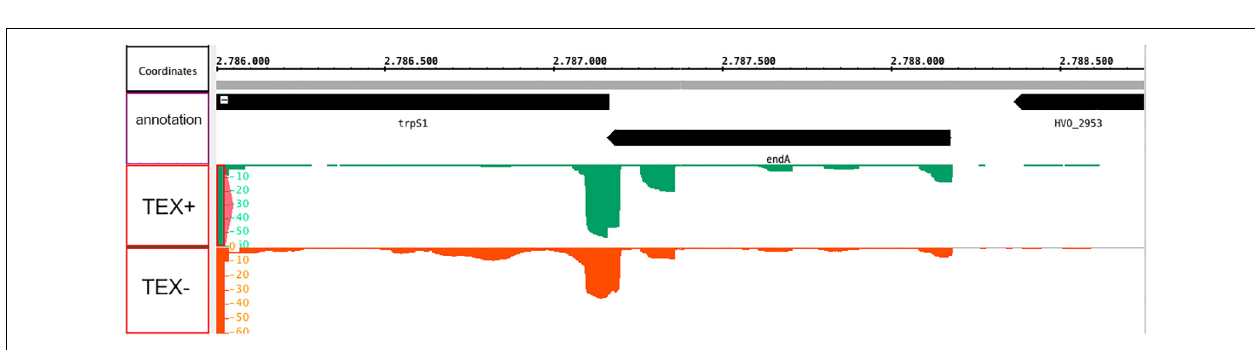
FIGURE 2 | Location of BHB motifs. (A) Three tRNAs contain an intron with the hBHBh (cid:48) motif forming at the exon-intron boundary. (B) hBHBh (cid:48) motifs are also flanking the 16S and 23S rRNAs. (C) General structure of the hBHBh (cid:48) motif. SE processing sites are indicated by green arrows.